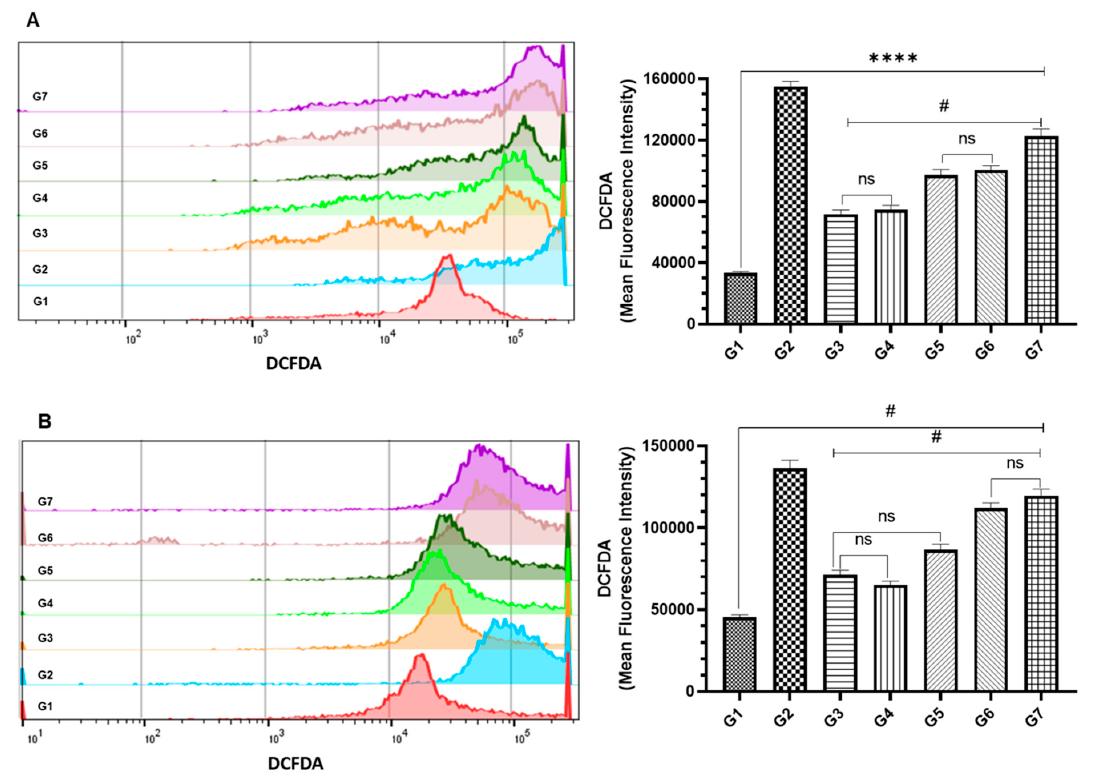
Figure 7. Effect of DCPDD and DCPDO on the induction of cellular ROS by flow cytometry as MFI of DCFDA in colon cancer cells: ( A ) HCT116 cells; ( B ) RKO cells. The doses of DCPDD were selected as IC 10 and IC 25 , while IC 10 of DCPDO is summarized in Table 2 in Materials